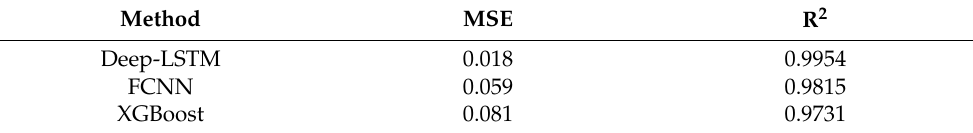
Figure 8. Test set training effect comparison ( a ) XGBoost model ( b ) FCNN model. Table 6. Comparison of NPV Training Accuracy of Different Algorithms.